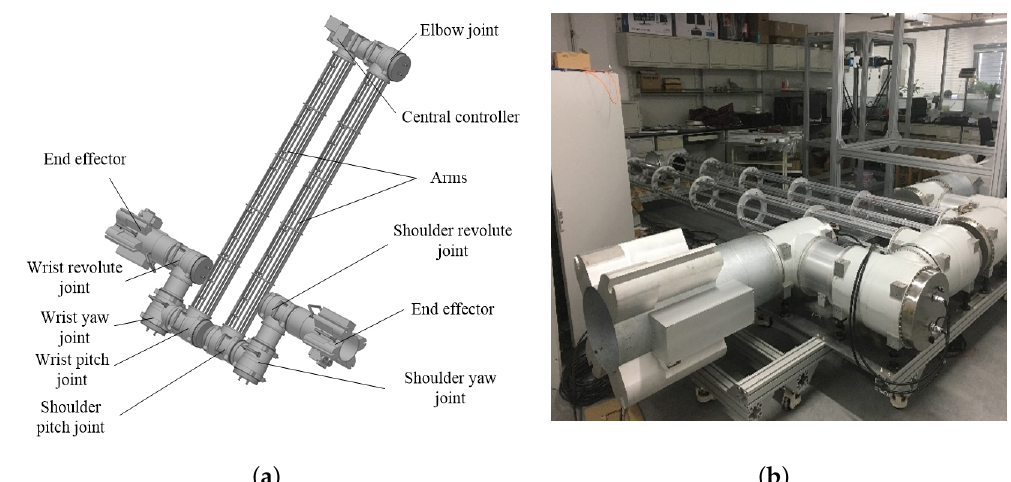
Figure 1. Structure of the simulated manipulator: ( a ) computer model; ( b ) mock-up.